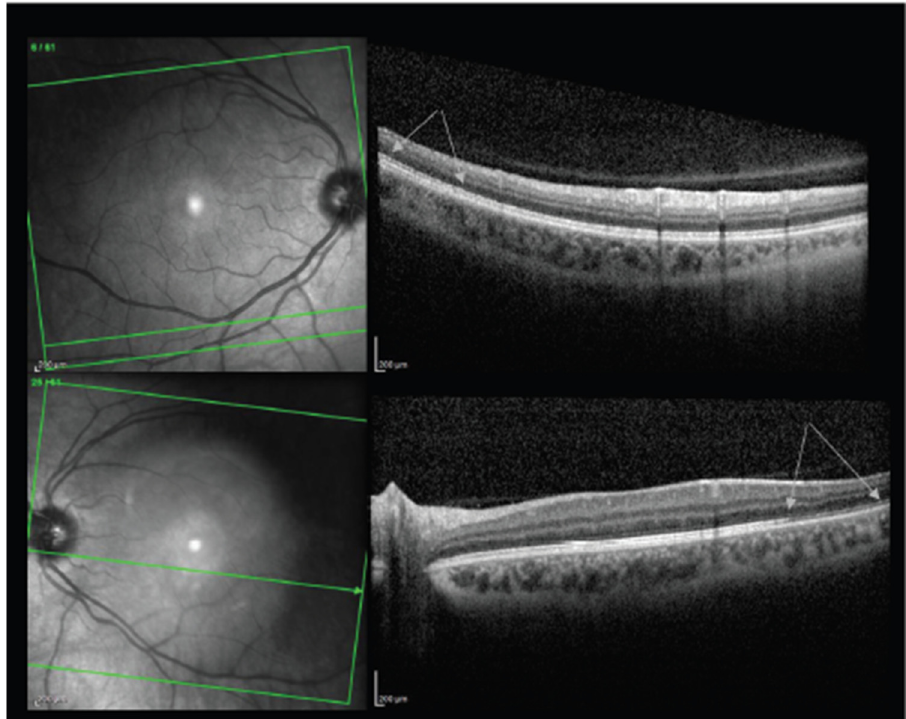
Figure 5. The upper and lower pictures are macular optical coherence tomography of the right and left eye, respectively. Arrows show the areas of disruption and segmentation of the ellipsoid zone in the right eye and thinning of (absent in some areas) ellipsoid zone in the left eye. Adapted from Maleki A, Look-Why S, Manhapra A, Foster CS. COVID-19 Recombinant mRNA Vaccines and Serious Ocular Inflammatory Side Effects: Real or Coincidence? J. Ophthalmic. Vis. Res. 2021 , 16 , 490–501; Published 29 July 2021. https://doi.org/10.18502/jovr.v16i3.9443 [53]. Figure 4, Copyright (2021)